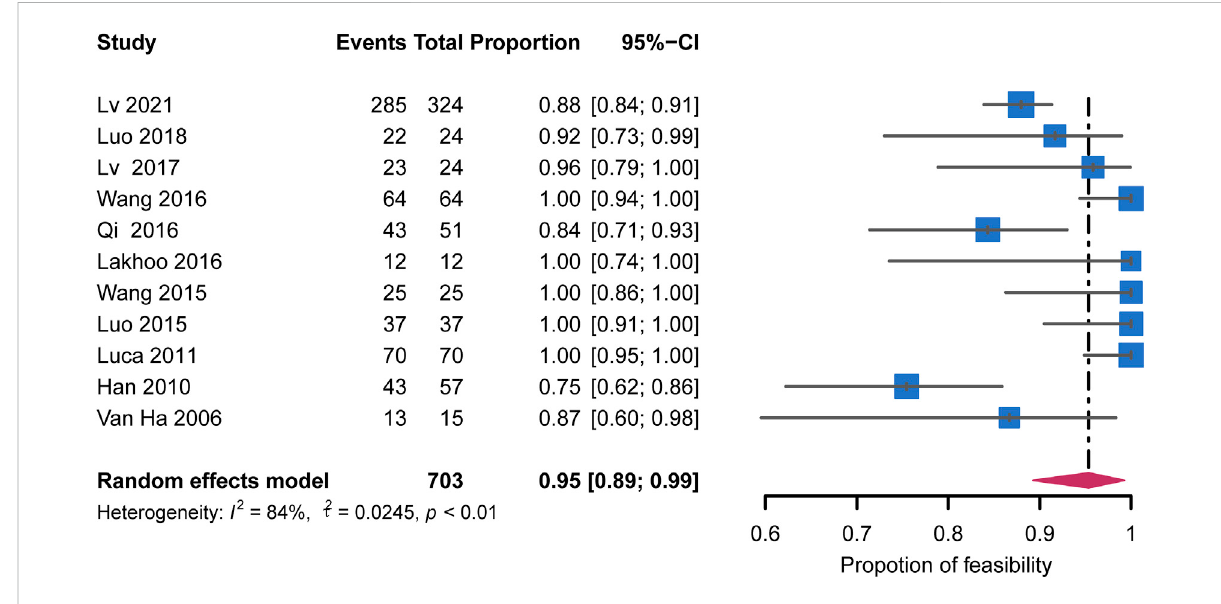
FIGURE 2 Forest plots for pooled rates of technical